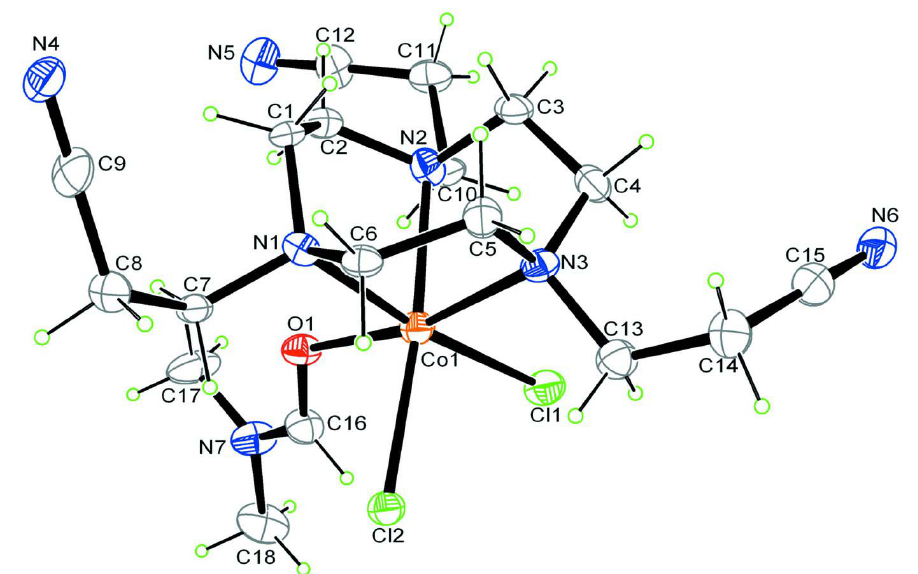
Figure 1 The molecular structure of the title compound, showing displacement ellipsoids at the 30% probability level (arbitrary sphere for H atoms).